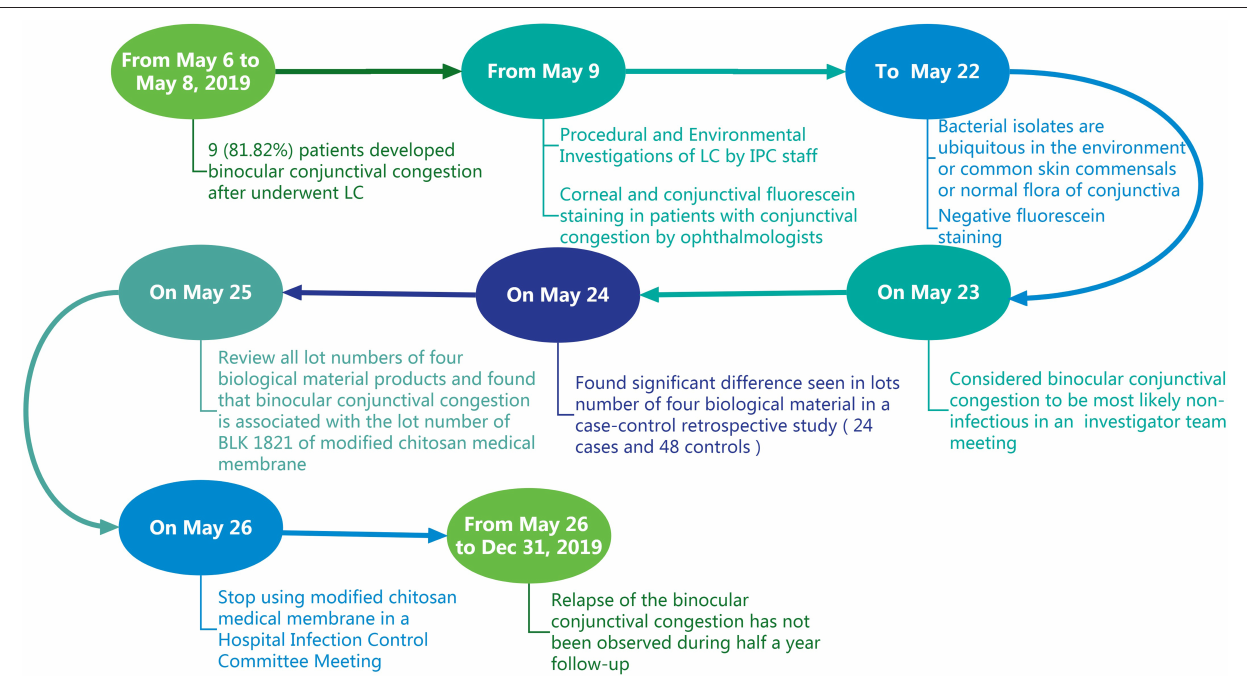
FIGURE 2 | A flow chart of the epidemiology investigation of a cluster of patients who presented with binocular conjunctival congestion after undergoing LC.